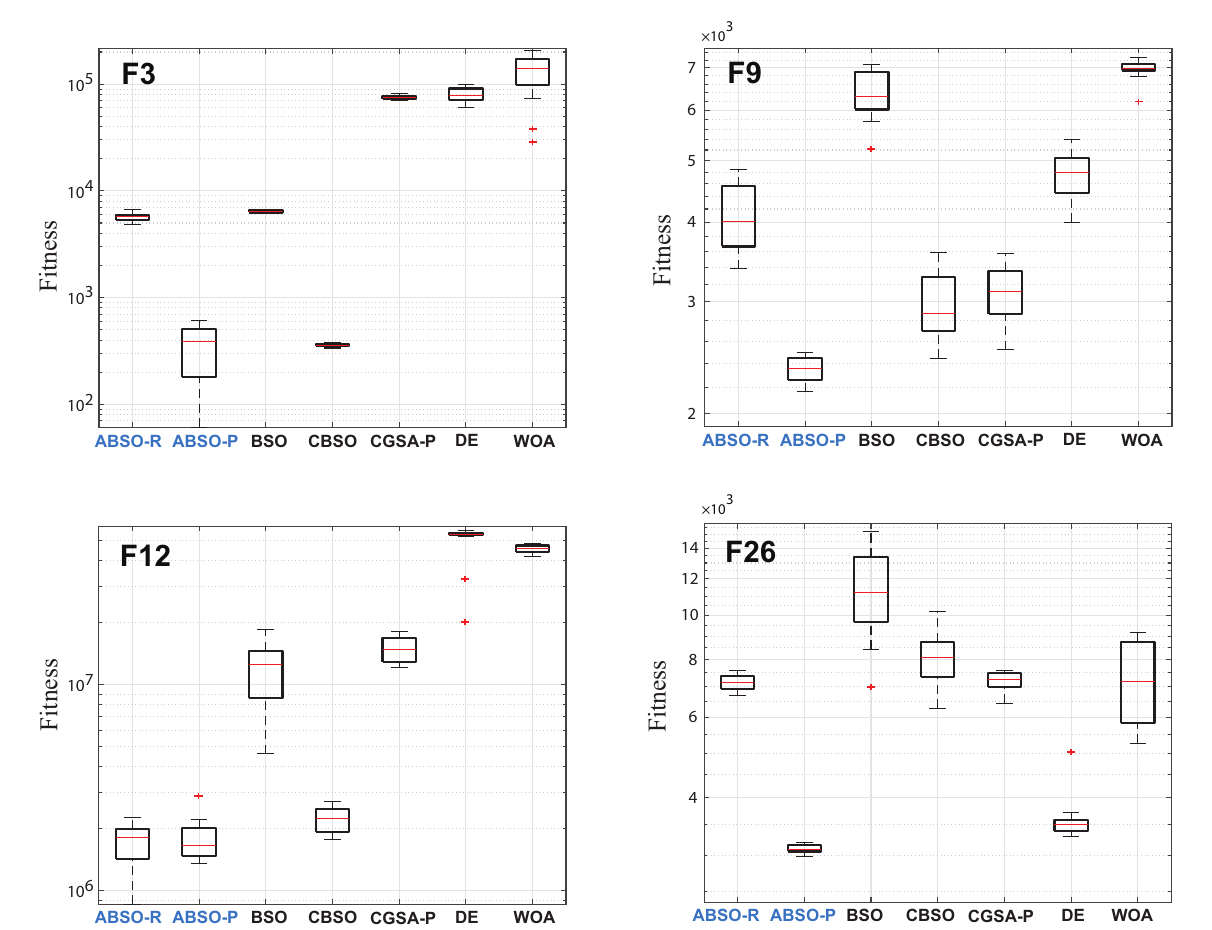
Figure 3. Box diagrams of each algorithm independently run 30 times on test functions F3, F9, F12, and